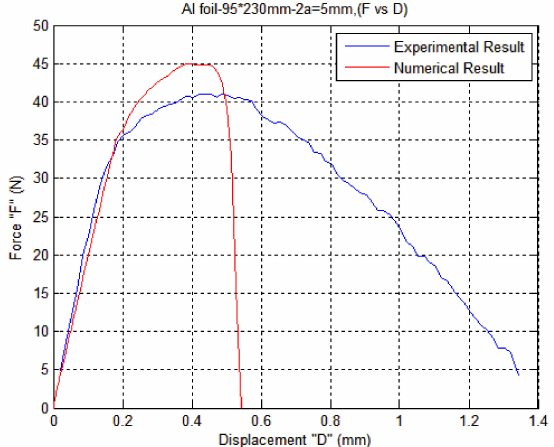
Figure 15. Force vs. displacement of aluminum foil with 5 mm